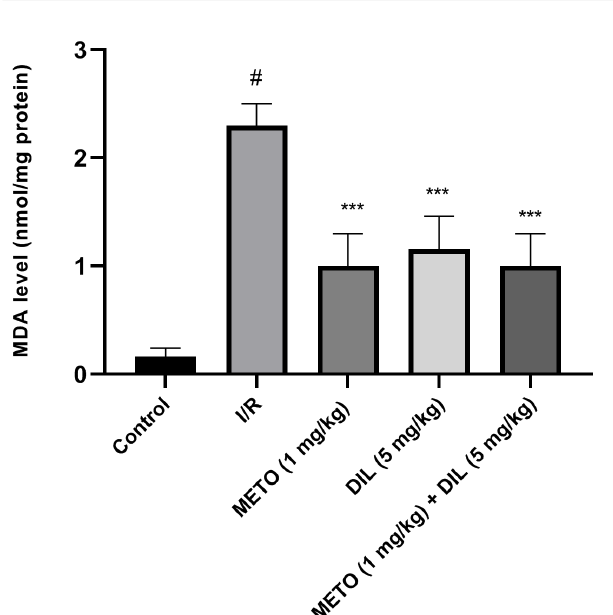
FIGURE 4 - The effects of pre-treatment with metoprolol (1 mg/kg/day) and diltiazem (5 mg/kg/day) alone and in combination on MDA level in the brain tissue; data are expressed as mean±S.E.M. N=6. # P<0.001 vs. control group. *** P<0.001 vs. I/R group using one-way ANOVA with Tukey post-test. I/R: Ischemia/reperfusion; METO: Metoprolol; DIL: